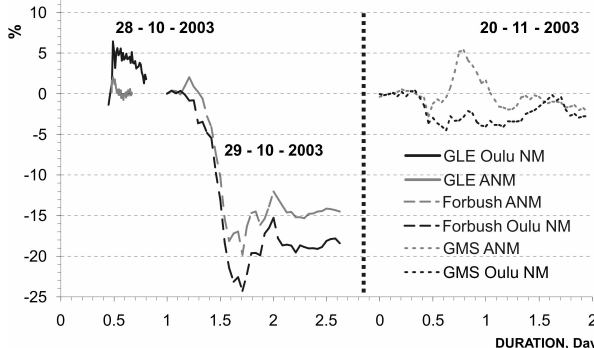
Fig. 1. 2003 Halloween events detected by particle detectors lo- cated at high latitude (Oulu NM, vertical cutoff rigidity ∼ 0.8GV, bold black curves) and middle latitude (Aragats NM (vertical cutoff rigidity ∼ 7.1GV, gray